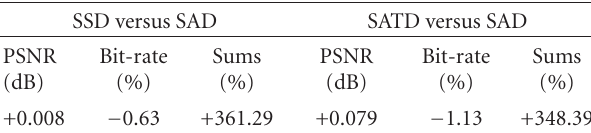
Table 1: Comparison among SAD, SSD, and SATD.